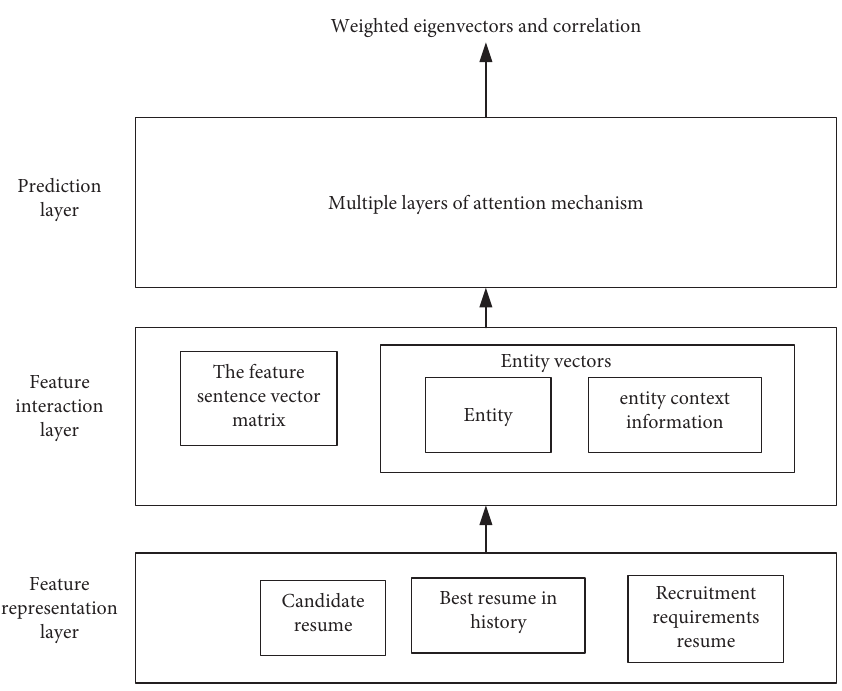
Figure 1: The structure of the KG-DPJF